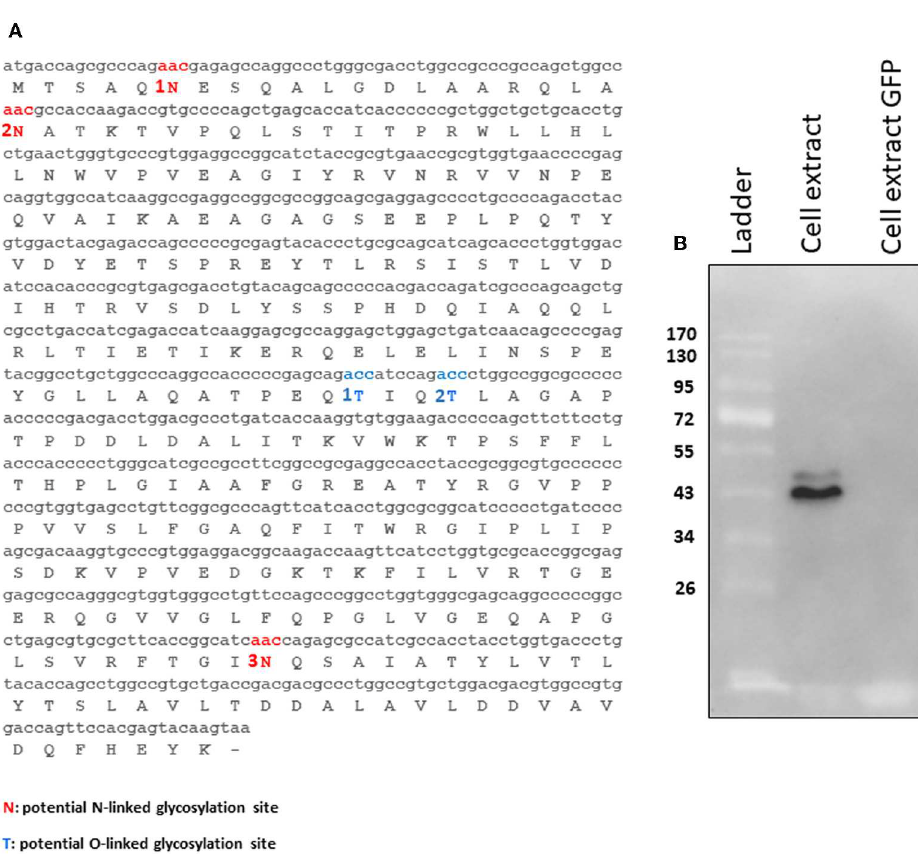
FIGURE 3 | (A) MMP N-linked (1N, 2N, and 3N in red) and O-linked (1T and 2T in blue) predicted glycosylation sites. (B) Western immunoblot of tPA-MMP secreted protein treated (Sup PNGase treated) or untreated (Sup untreated) with PGNase F. Cell extracts from pEF1 α -tPA-MMP (Cell extract) and pEGFP-C1 (Cell extract GFP) transfected HEK 293T cells were used as positive and negative controls,